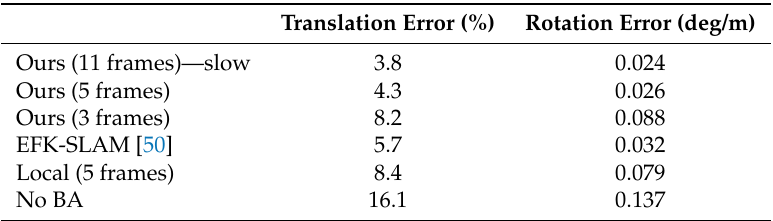
Table 2. A comparison of translational and rotational errors for several methods and parameters. The trajectory estimation performed in Agisoft Photoscan was considered to be a